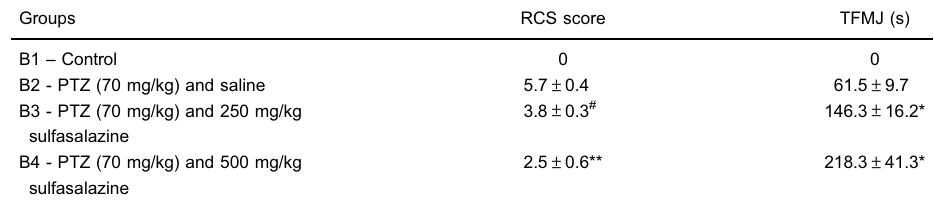
Table 2. Improvement in Racine ’ s convulsion scale (RCS) and time of fi rst myoclonic jerk (TFMJ) with sulfasalazine.